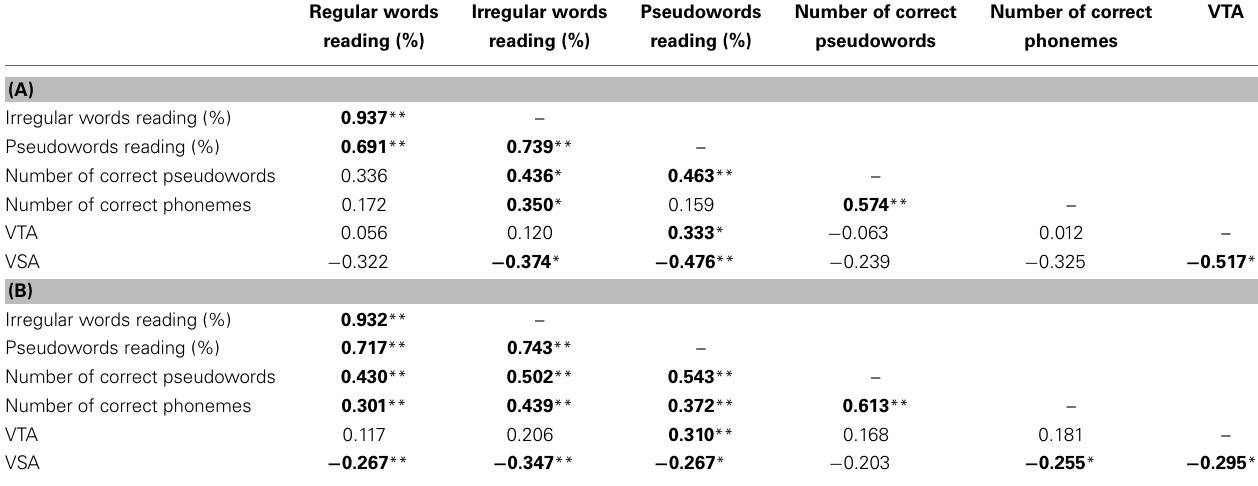
Table 6 | Descriptive Statistics of variables included in the multiple regression analysis: age (month), Performance IQ (Figure Completion, Wechsler, 1993), pseudoword reading accuracy, time-course of visual spatial attention (VSA; RT difference between cuing effect at 350 and 100ms SOA) and time-course of visual temporal attention (VTA; identification accuracy mean in O + noise condition), and pseudowords phoneme blending (PPB; number of correct pseudowords) in dyslexic children ( N = 32).